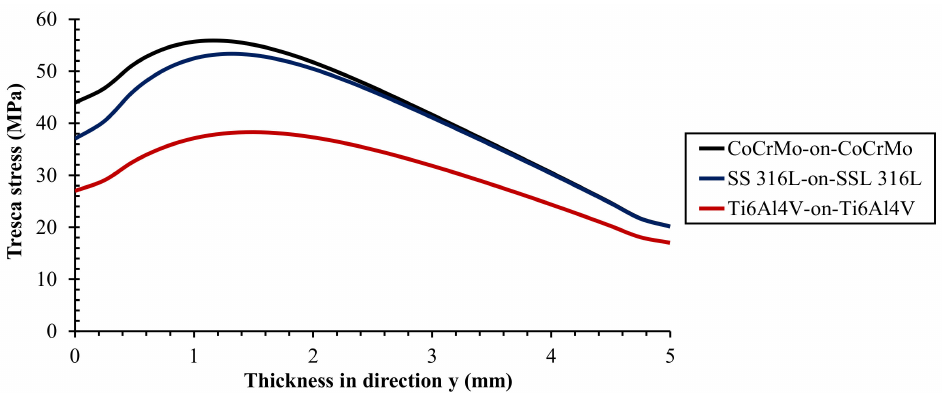
Figure 6. Tresca stress profile as a function of acetabular cup thickness for different metal-on-metal bearing materials at peak loading.